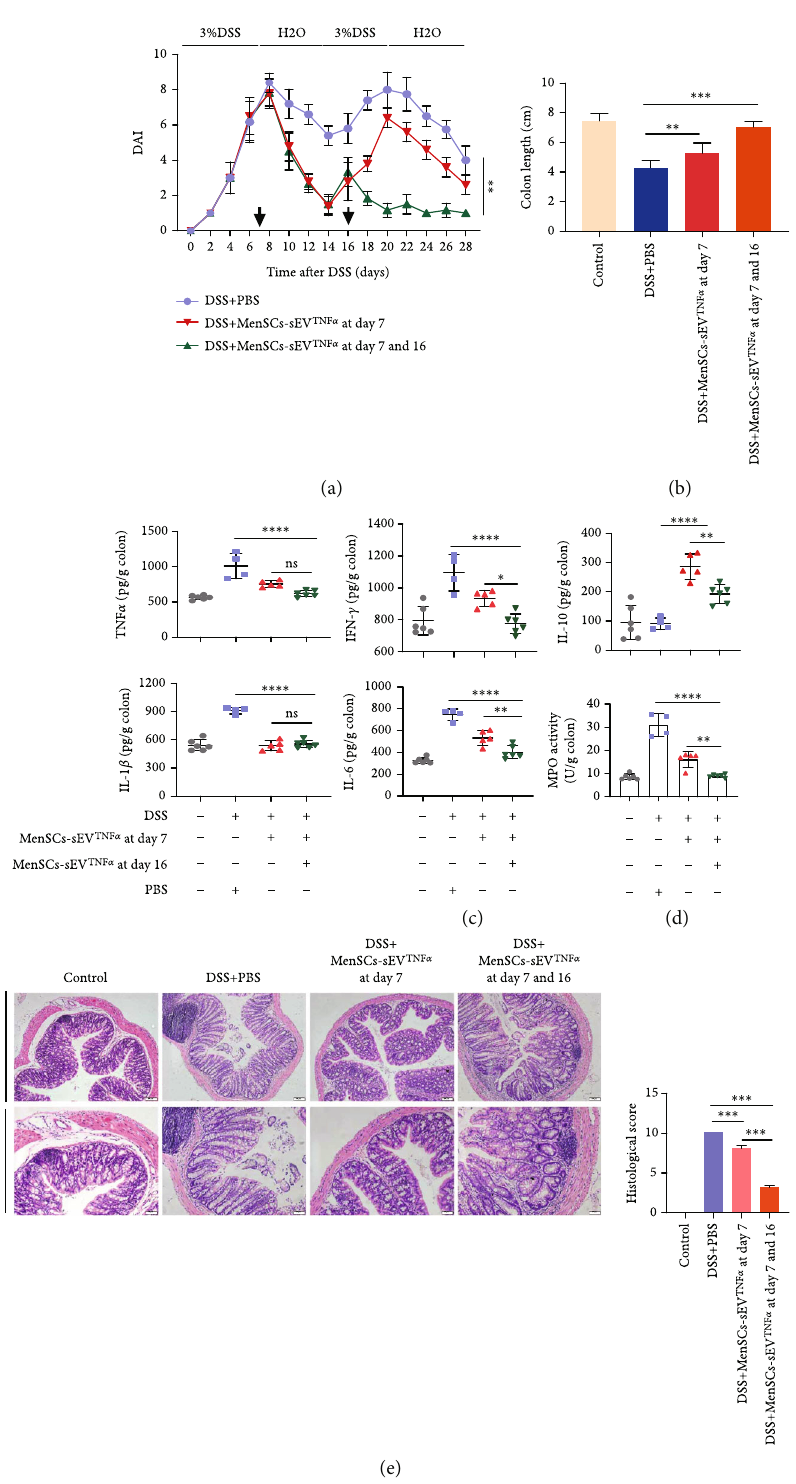
Figure 4: MenSCs-sEV TNF- α relieves chronic recurrent colitis caused by DSS. Male C57 BL/6 mice ( n = 6 ) aged 6-8 weeks were given normal water for 7 days after 3% DSS solution for 1 week. The treatment was repeated once and small EVs were intraperitoneally injected into the DSS+MenSCs-sEV TNF- α group on day 7 and day 16 (200 μ g/mouse). (a) The clinical symptoms of the mice were recorded daily as DAI scores, which were based on the varying degrees of weight loss, stool consistency, and hematochezia. (b) The length of the colon of each mouse was measured after euthanasia. (c) The levels of TNF- α , IFN- γ , IL-10, IL-1 β , and IL-6 in colon tissue were measured by ELISA. (d) Neutrophil in fi ltration in the colon was detected by MPO activity. (e) Colon tissues were stained with hematoxylin and eosin to observe the in fl ammatory in fi ltration and structural integrity. Original magni fi cation: × 100 (up) and × 200